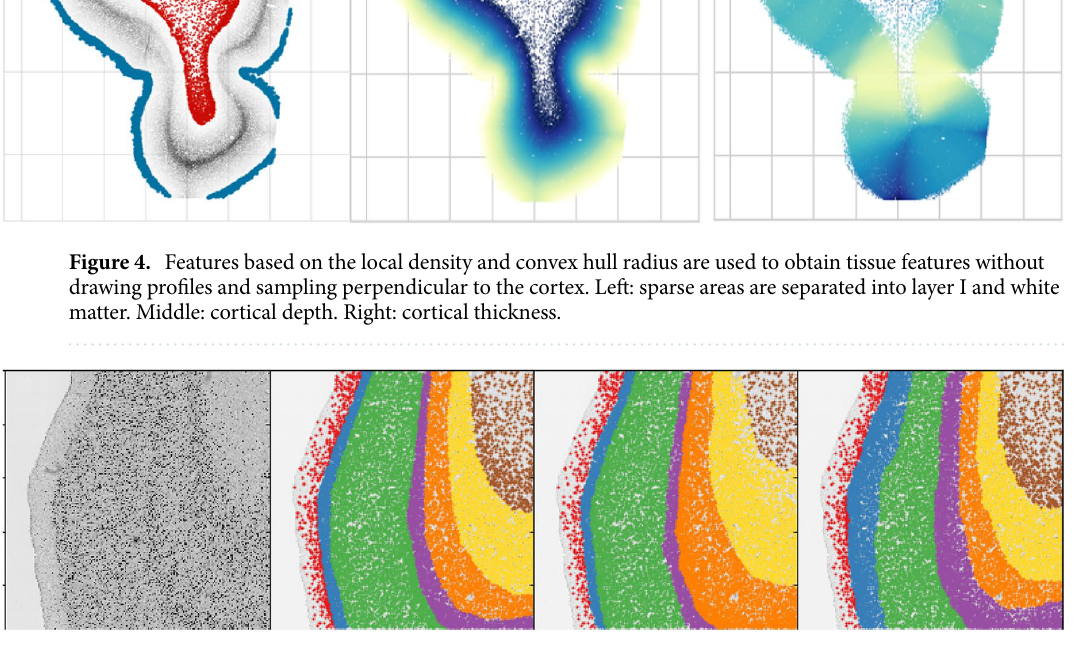
Figure 5. A detail of cortical layers manually delineated by the experts. Significant disagreement is observed on the boundaries of the layers, as well as on positioning the boundary between the cortex and the white